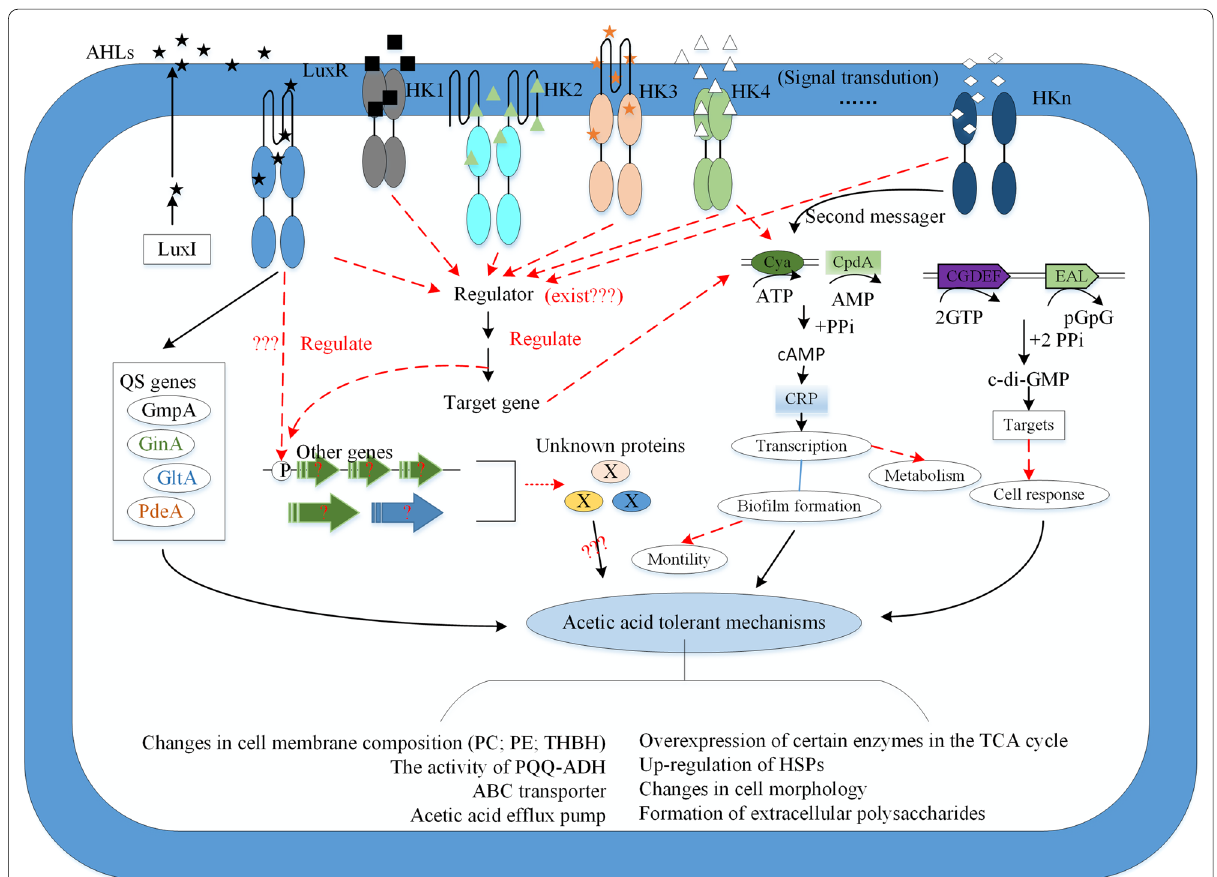
Fig. 2 The possible quorum sensing system model in Komagataeibacter and Gluconacetobacter . The red dotted line and “?” refer to the potential relationship or the process have not been identified. The abbreviation of HK refer to histidine